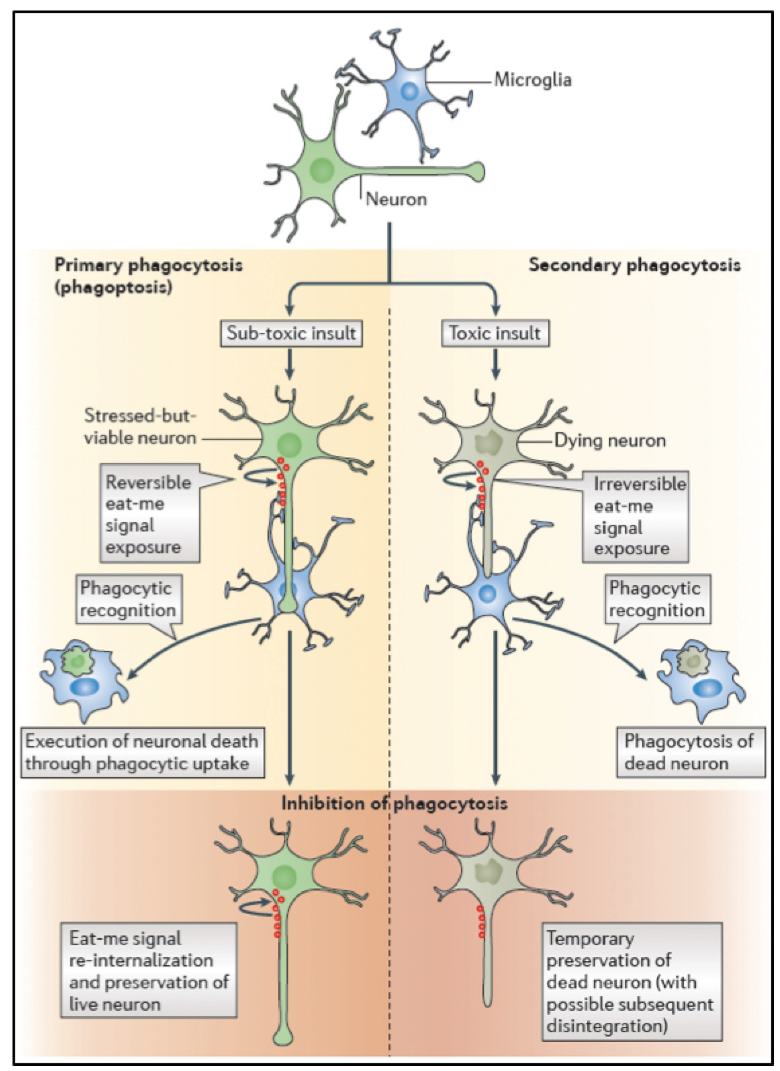
Figure 2. Phagocytosis and phagoptosis. Recent data indicate that phagocytosis can execute the death of viable neurons during development, inflammation, and neuropathology. This form of cell death is called phagoptosis, which means that cell death is caused by the cell being phagocytosed, with the defining characteristic that inhibition of phagocytosis or phagocytic signalling prevents cell death. Experimentally distinguishing between primary phagocytosis (that is, phagoptosis) and secondary phagocytosis (that is, the phagocytosis of a cell dying by apoptosis or necrosis) is possible through inhibiting phagocytosis, which in the first case will leave live cells, whereas in the second case it will leave dead cells (at least temporarily before their disintegration). [Figure and legend reproduced with permission from: Brown GC & Neher JJ.; Nat Rev Neurosci 2014 4